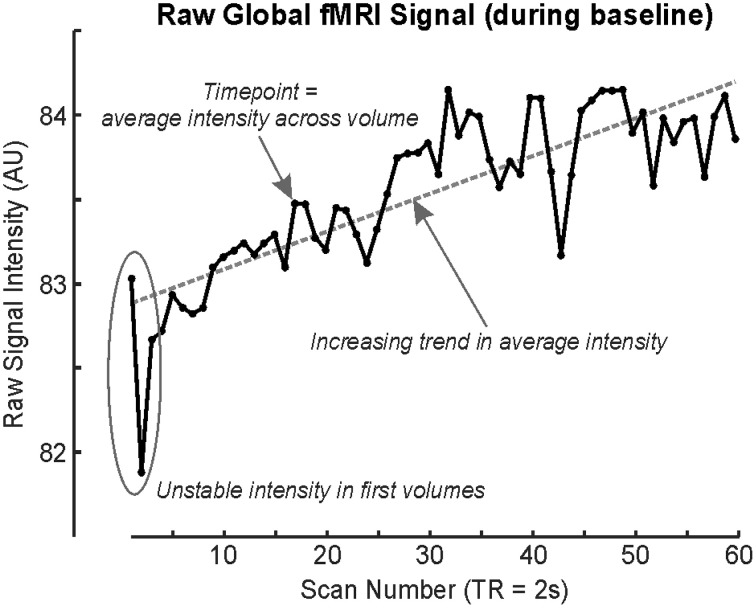
fMRI time series' global signal illustrating drift during a baseline (rest) period, with each timepoint representing the average signal intensity across the whole brain volume (scan). First fMRI scans are usually rejected due to time taken for the signal to stabilize (although modern sequences do this automatically; Data from single subject baseline of cold pressor in Macey et al., 2012).